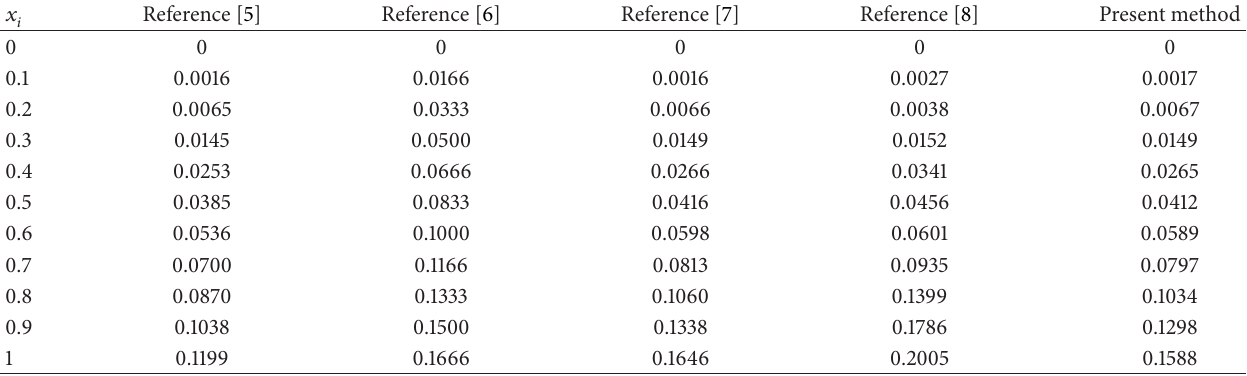
Table 4: A numerical comparison of the approximate solution to Example 5 when 𝑘 = 10 for different values of 𝑥 in [0,1] . 𝑥